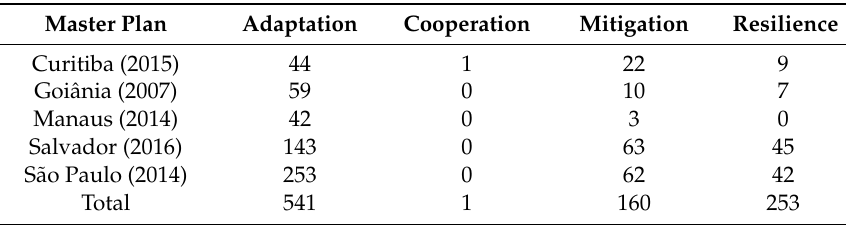
Table 7. Climate action references in master